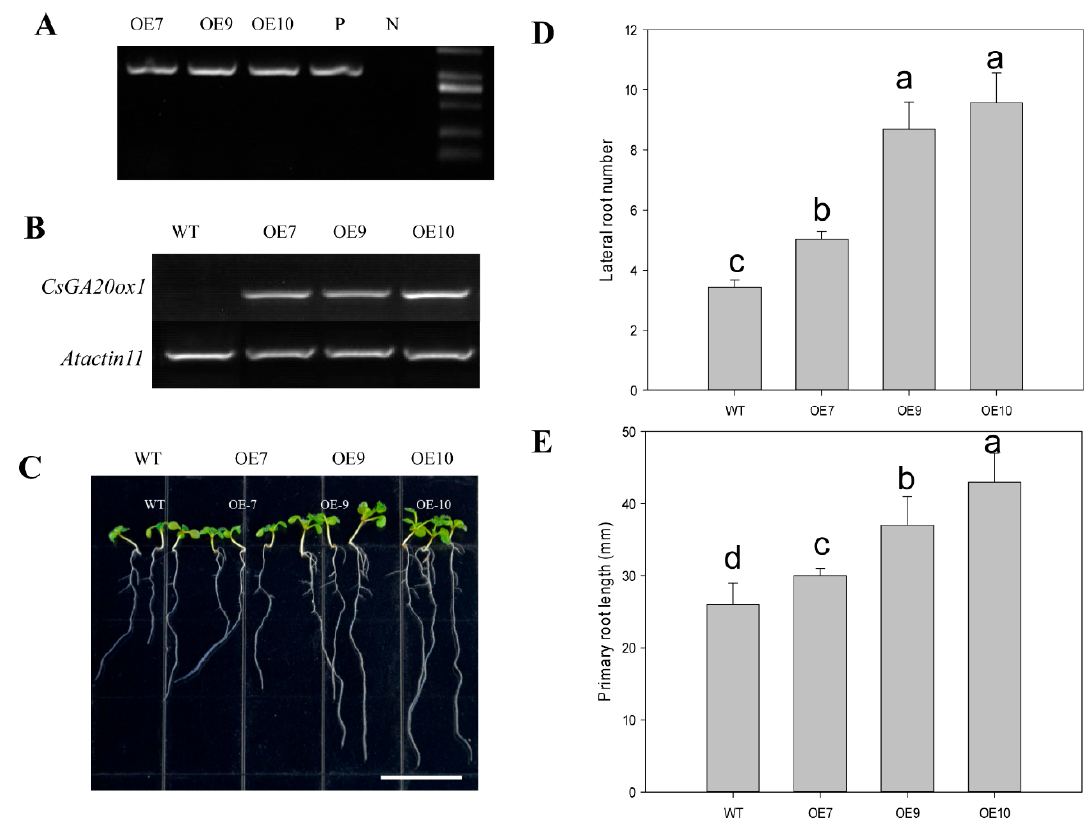
Figure 5. Ectopic expression of CsGA20ox1 in Arabidopsis . ( A ) Arabidopsis transformants were confirmed by Polymerase chain reaction (PCR) using CaMV35S promoter specific forward primer together with CsGA20ox1 reverse primer; ( B ) Relative expression of CsGA20ox1 in Col-0 and three T3 generation transgenic lines. Total RNA was extracted from 10-day-old seedlings, then analyzed by semi-quantitative RT-PCR. The AtActin11 gene was used as an internal control; ( C ) The morphology of 10-day-old seedlings of Col-0 and three over-expression (OE) lines; ( D , E ) Lateral root number ( D ) and the primary root length ( E ) in 10-day-old wild type (Col-0) and three OE lines. Values are the means with SE ( n = 8–10). Different letters indicate significant differences between means (ANOVA with Tukey’s HSD test, p < 0.05).